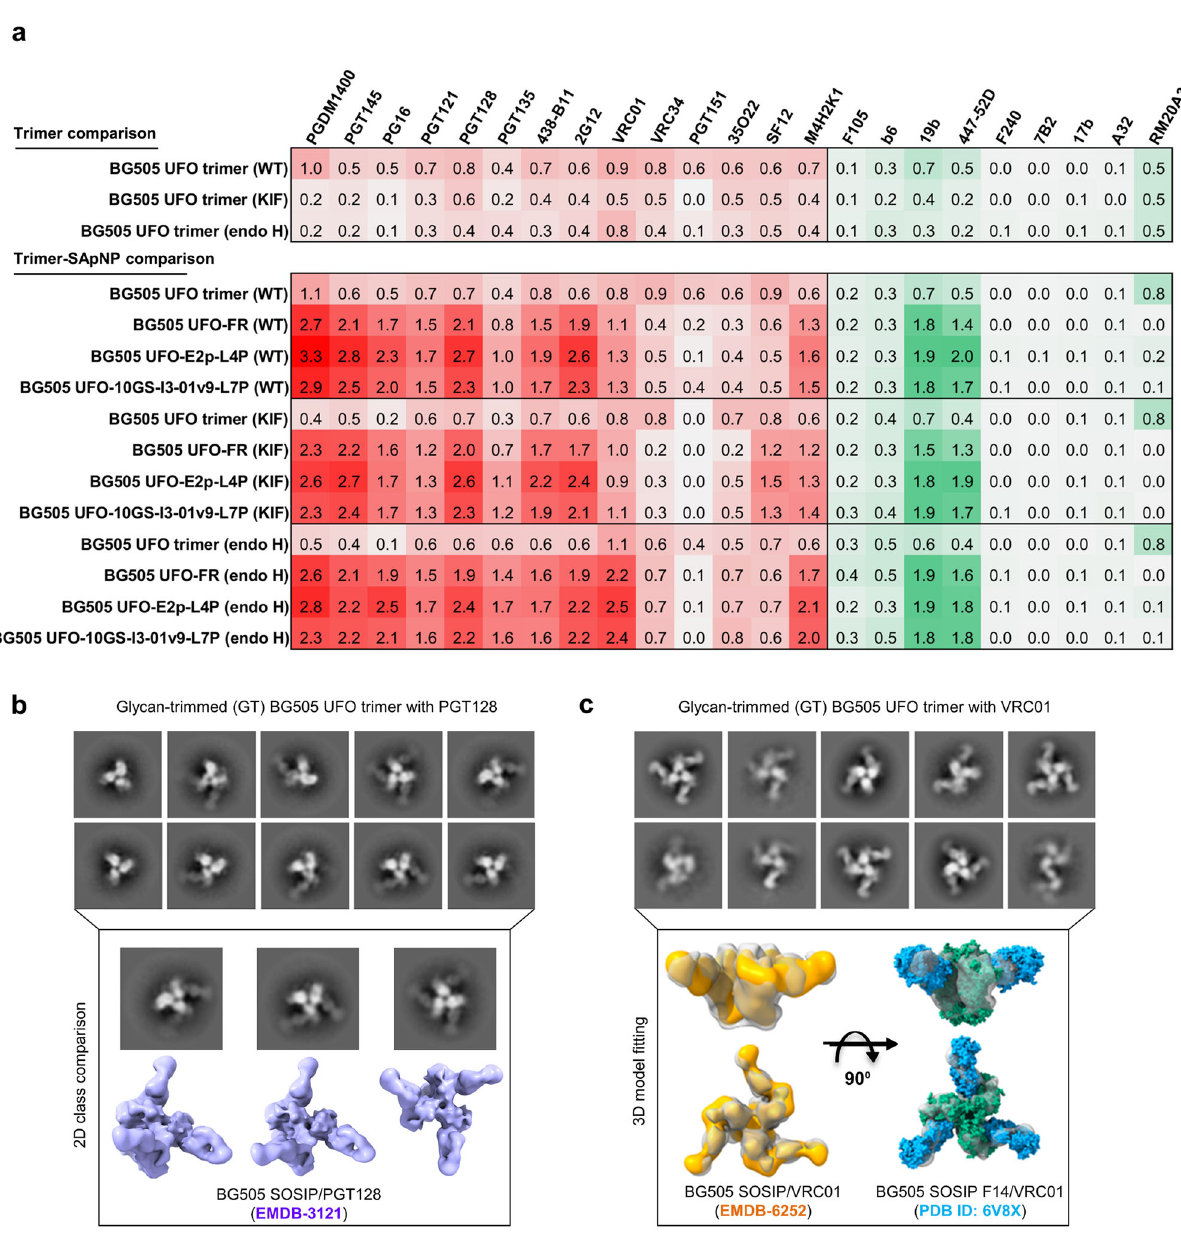
Higher color intensity indicates greater binding signal measured by Octet. b Negative-stain EM analysis of the glycan-trimmed BG505 UFO trimer in complex withbNAbPGT128.Examplesof 2Dclassimages(top)and comparisonwithacryo- EMmodelofBG505SOSIP/PGT128complex(bottom,EMDB-3121,corn fl owerblue). c Negative-stain EM analysis of the glycan-trimmed BG505 UFO trimer in complex with bNAb VRC01. Examples of 2D class images (top) and superposition of the 3D reconstruction onto two previously reported BG505 SOSIP/VRC01 models derived from negative-stain EM (EMDB-6252, orange) and cryo-EM (PDB ID: 6V8X, cyan and